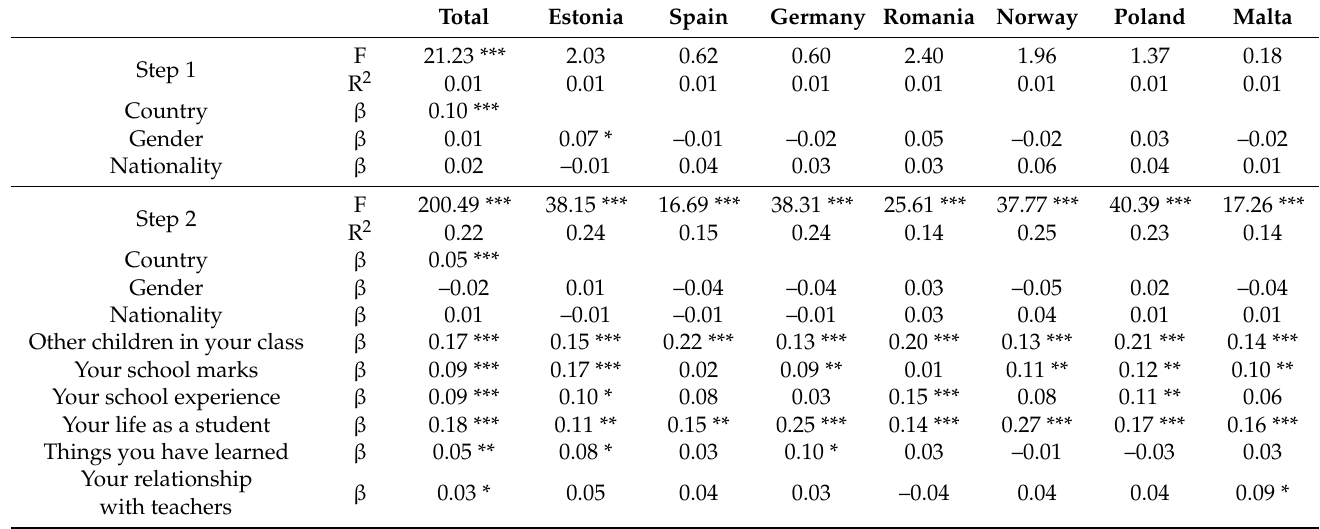
Table 5. Hierarchical regression analyses to explain child happiness based on demographics and school satisfaction indicators in the total sample and by